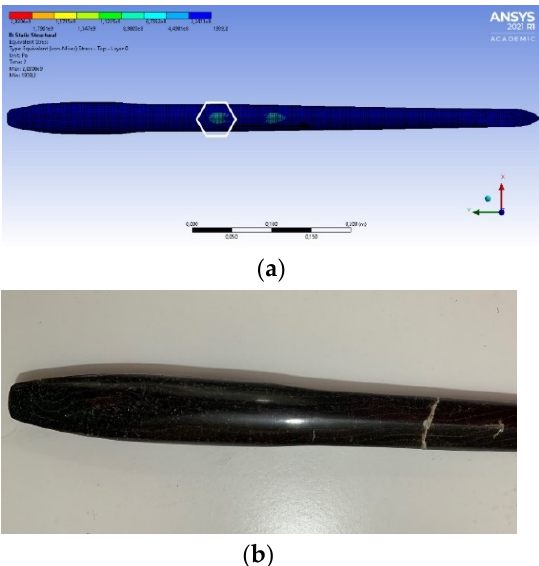
Figure 18 . ( a ) Displacement and ( b ) equivalent stress of CFRP-UD/Twill fuselage . Figure 18. ( a ) Displacement and ( b ) equivalent stress of CFRP-UD/Twill